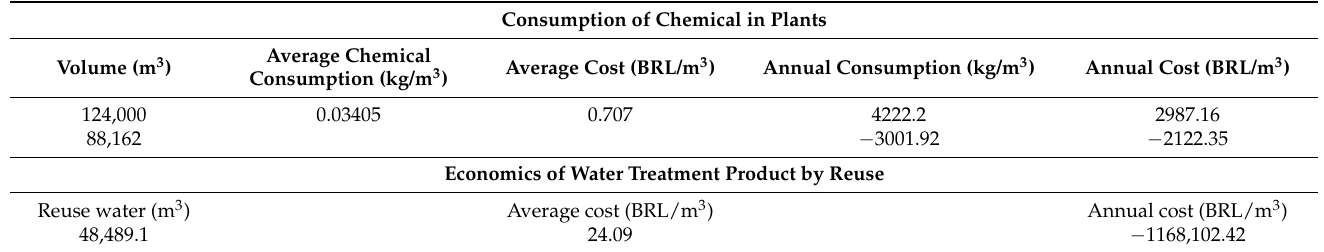
Table 6. Annual costs (BRL) with water treatment